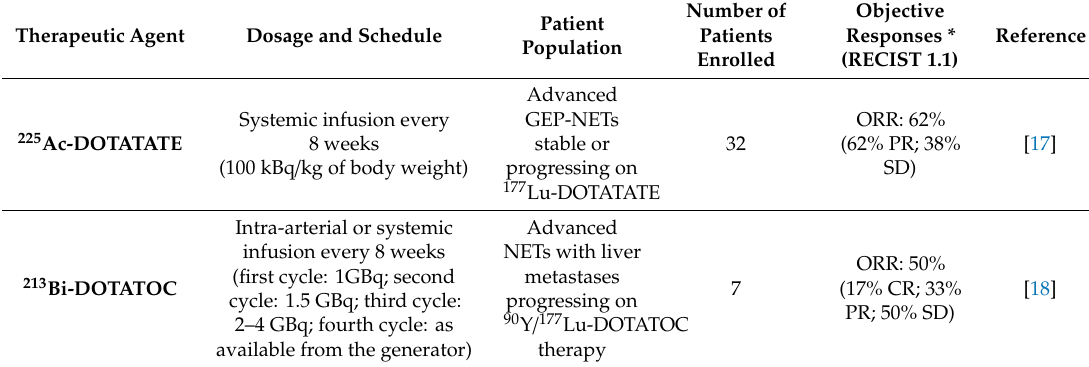
Table 1. Clinical trials of PRRT with alpha-emitters or somatostatin antagonists in patients with NETs. Therapeutic